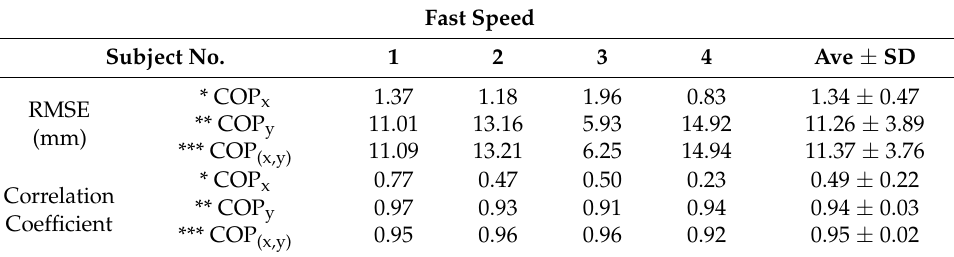
Table 5. RMSE results and the correlation between I-TCPs and F-scan in fast gait speed. Fast